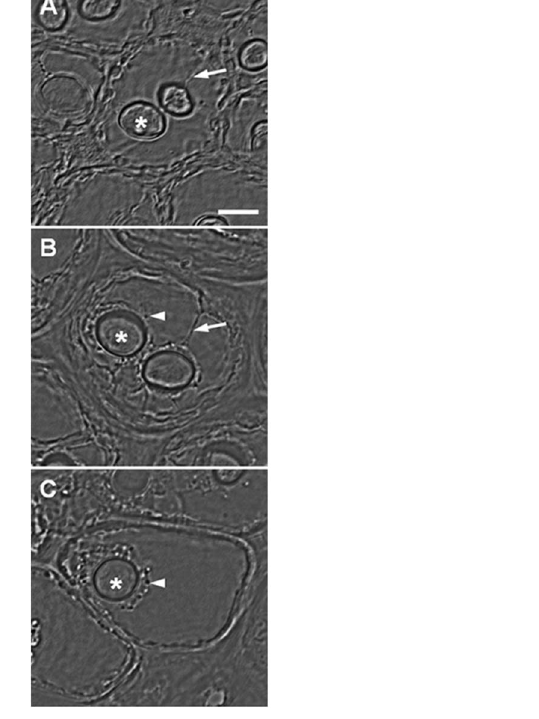
Figure 3. Alga cells treated with latrunculin B. (A) Control, (B) Lat 0.1 m M, (C) Lat 1 m M. *= CC , arrows =membranous connections, arrowheads=vesicles. Note the gradual vesicle accumulation surround- ing the CC (B,C) and the disruption of connective structures between the CC and the cell periphery (C). Bar=9 m m.